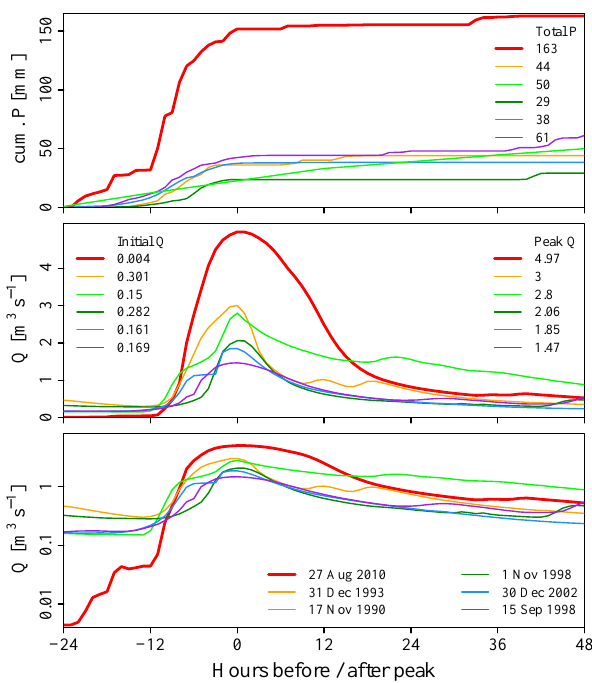
Fig. 10. Cumulative precipitation (top) and discharge on linear (middle) and logarithmic axis (bottom) of the six highest discharges since 1969.